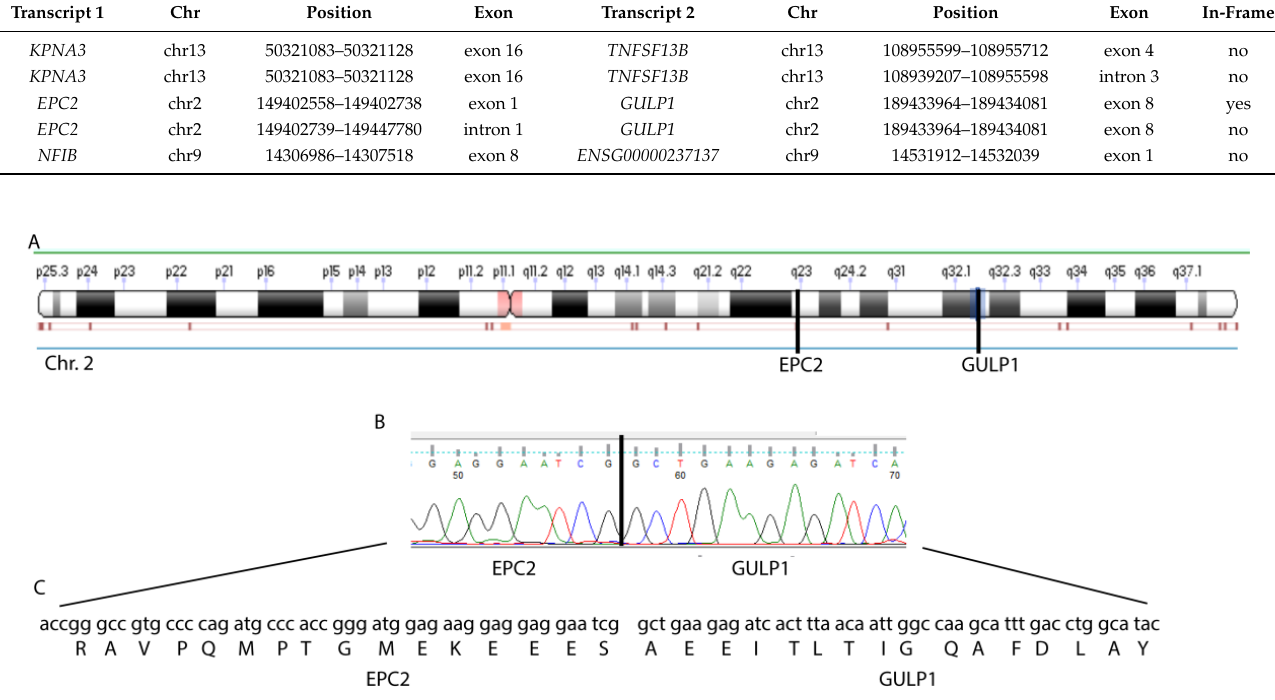
Figure 1. Detection of the EPC2–GULP1 Fusion. ( A ) Position of EPC2 and GULP1 on chr.2. ( B ) Sanger sequencing showing the sequence of the fusion position. ( C ) Protein sequence of the fusion transcript predicted by NGS and validated by Sanger sequencing.